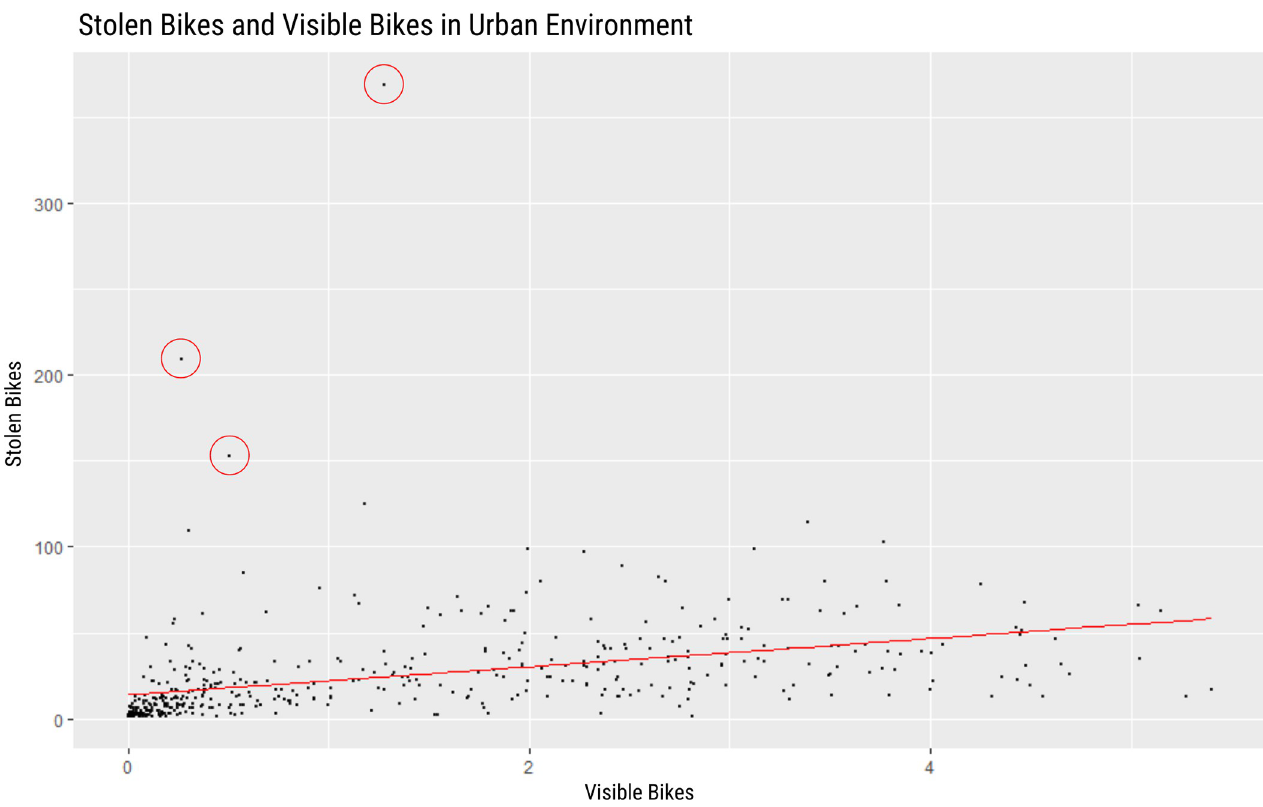
Fig 7. Stolen bikes and average number of bikes in the images. The linear model is represented by the red line.